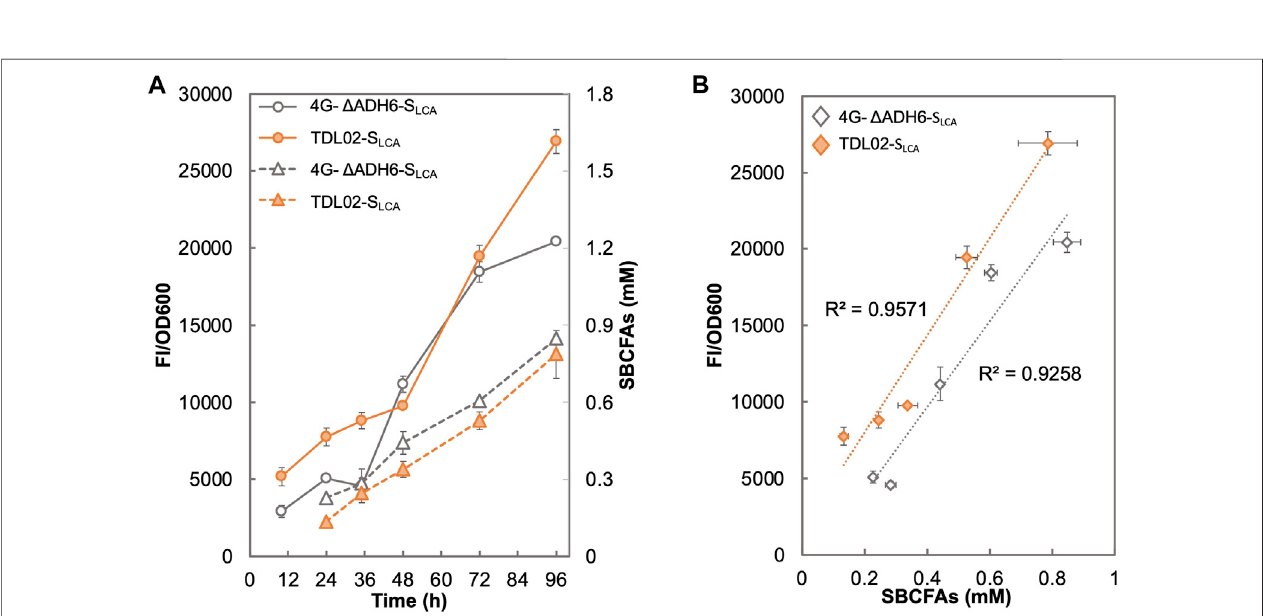
FIGURE 5 | Responses of SBCFA biosensor in a S. cerevisiae strain overproducing SBCFAs. PDR12 was deleted in a previously engineered SBCFA- overproducing strain 4G- Δ ADH6, resulting in strain TDL02. The biosensor S LCA was introduced into TDL02 and 4G- Δ ADH6 respectively. (A) The fl uorescence (solid lines)andtheover-producedSBCFAs(dottedlines)weremeasuredafterfermentationinbufferedSCD-U(atpH6.5)mediumforupto96 h. (B) CorrelationbetweenGFP fl uorescence with SBCFAs produced in 4G- Δ ADH6-S 2 value are shown in orange (4G- Δ ADH6-S LCA and TDL02-S LCA . Trendlines with respective R LCA ) and grey (TDL02-S LCA ). Values are the means of three independent experiments, and an error bar represents a standard deviation of three independent experiments.